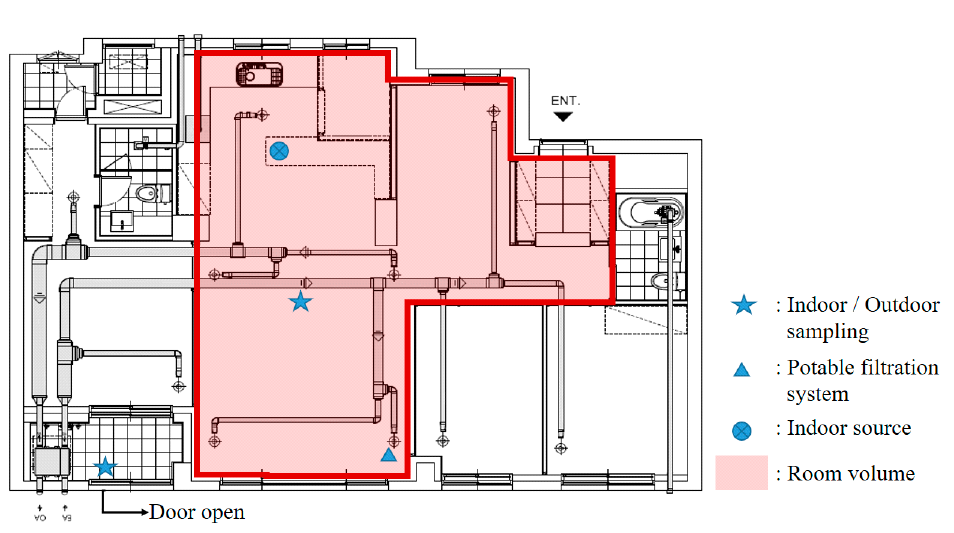
Figure 3. Configuration of the experimental house: system layout, sampling locations, and emission point.